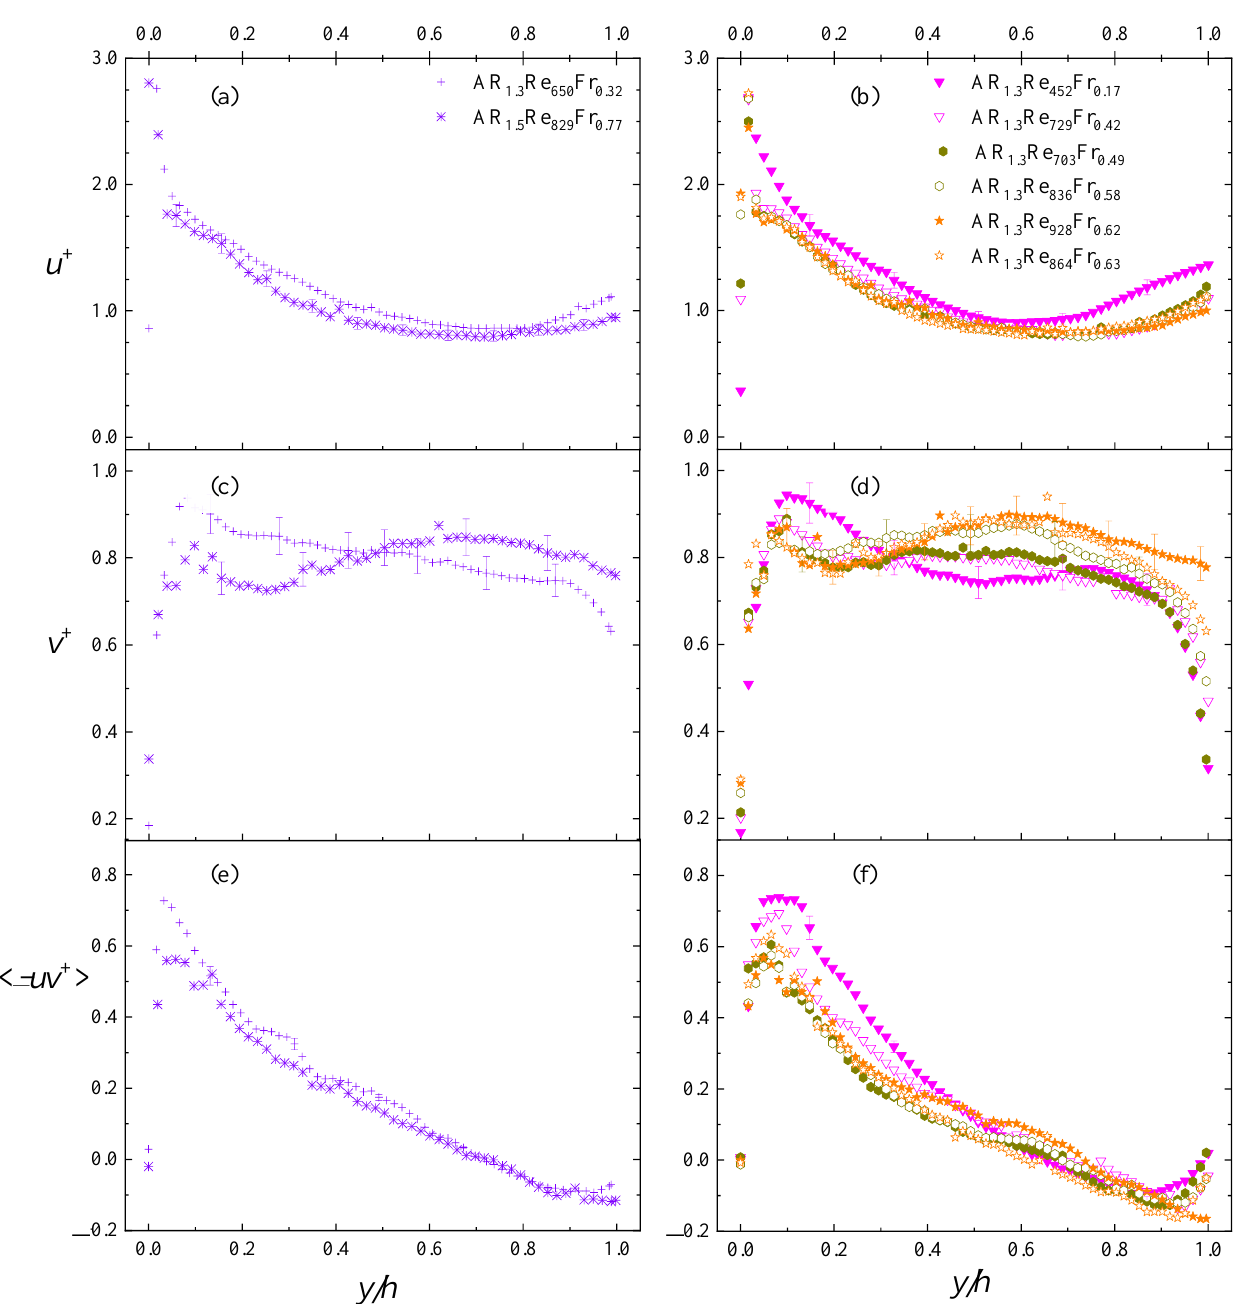
Figure 10. Variations of normalized streamwise turbulence intensity u + ( a , b ), wall-normal turbulence intensity v + ( c , d ), and Reynolds shear stress < − uv + > ( e , f ), with the normalized wall-normal location y / h . This is conducted for selected test conditions to highlight effects of Fr ( a , c , e using the same legend) and the combination of Re 𝜃 and Fr ( b , d , f using the same legend).